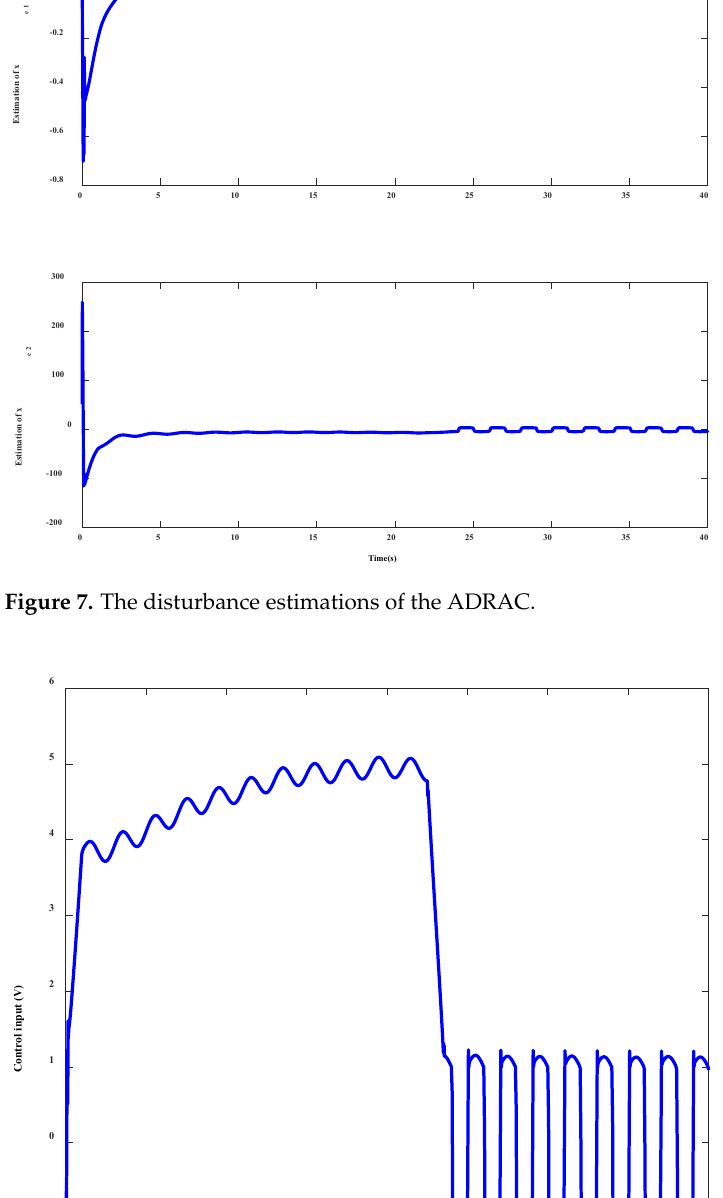
Figure 8. The control input of the ADRAC.